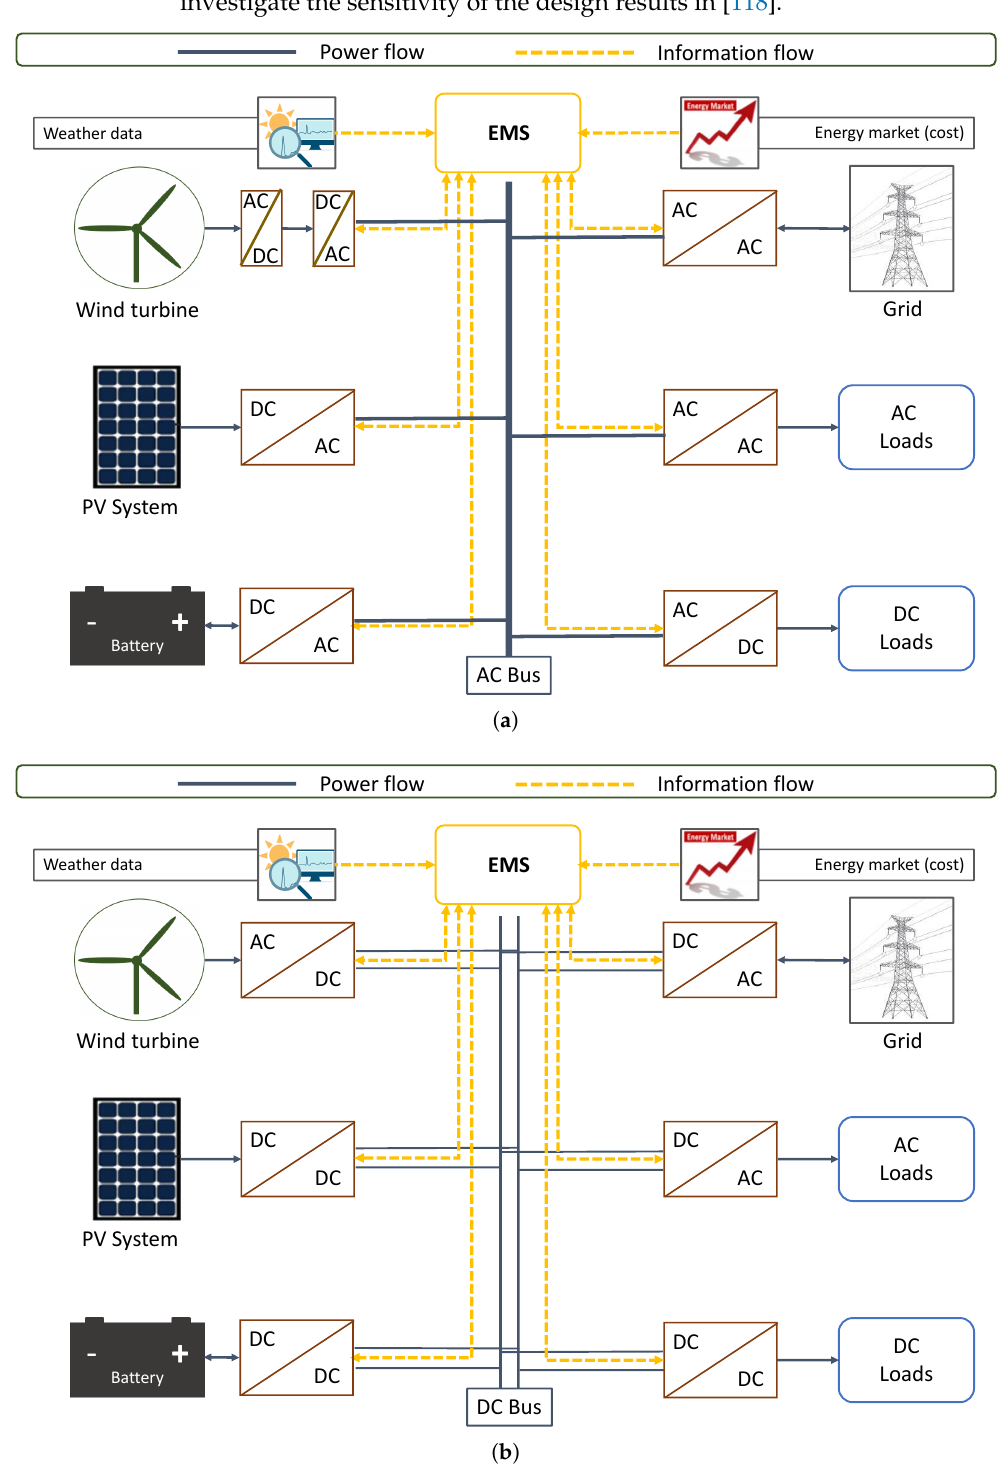
Figure 10. Renewable resources-based AC and DC microgrids architecture. ( a ) AC microgrid topology. ( b ) DC micro- grid